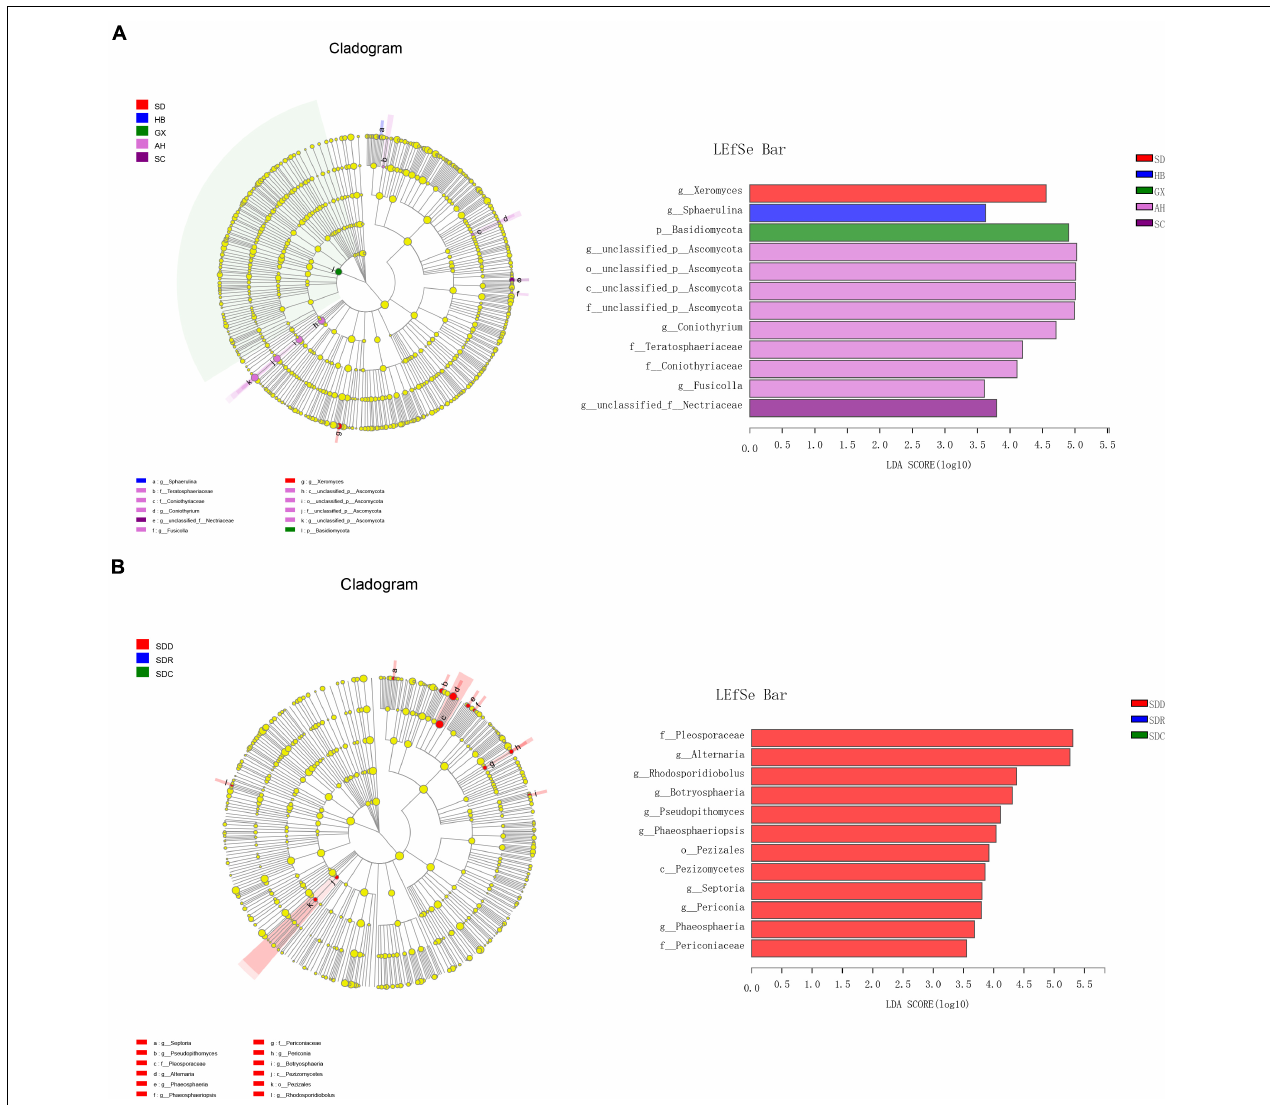
FIGURE 6 | Fungal taxa with different abundances by linear discriminant analysis effect size (LEFSe) analysis in (A) groups based on collection areas and (B) groups based on processing